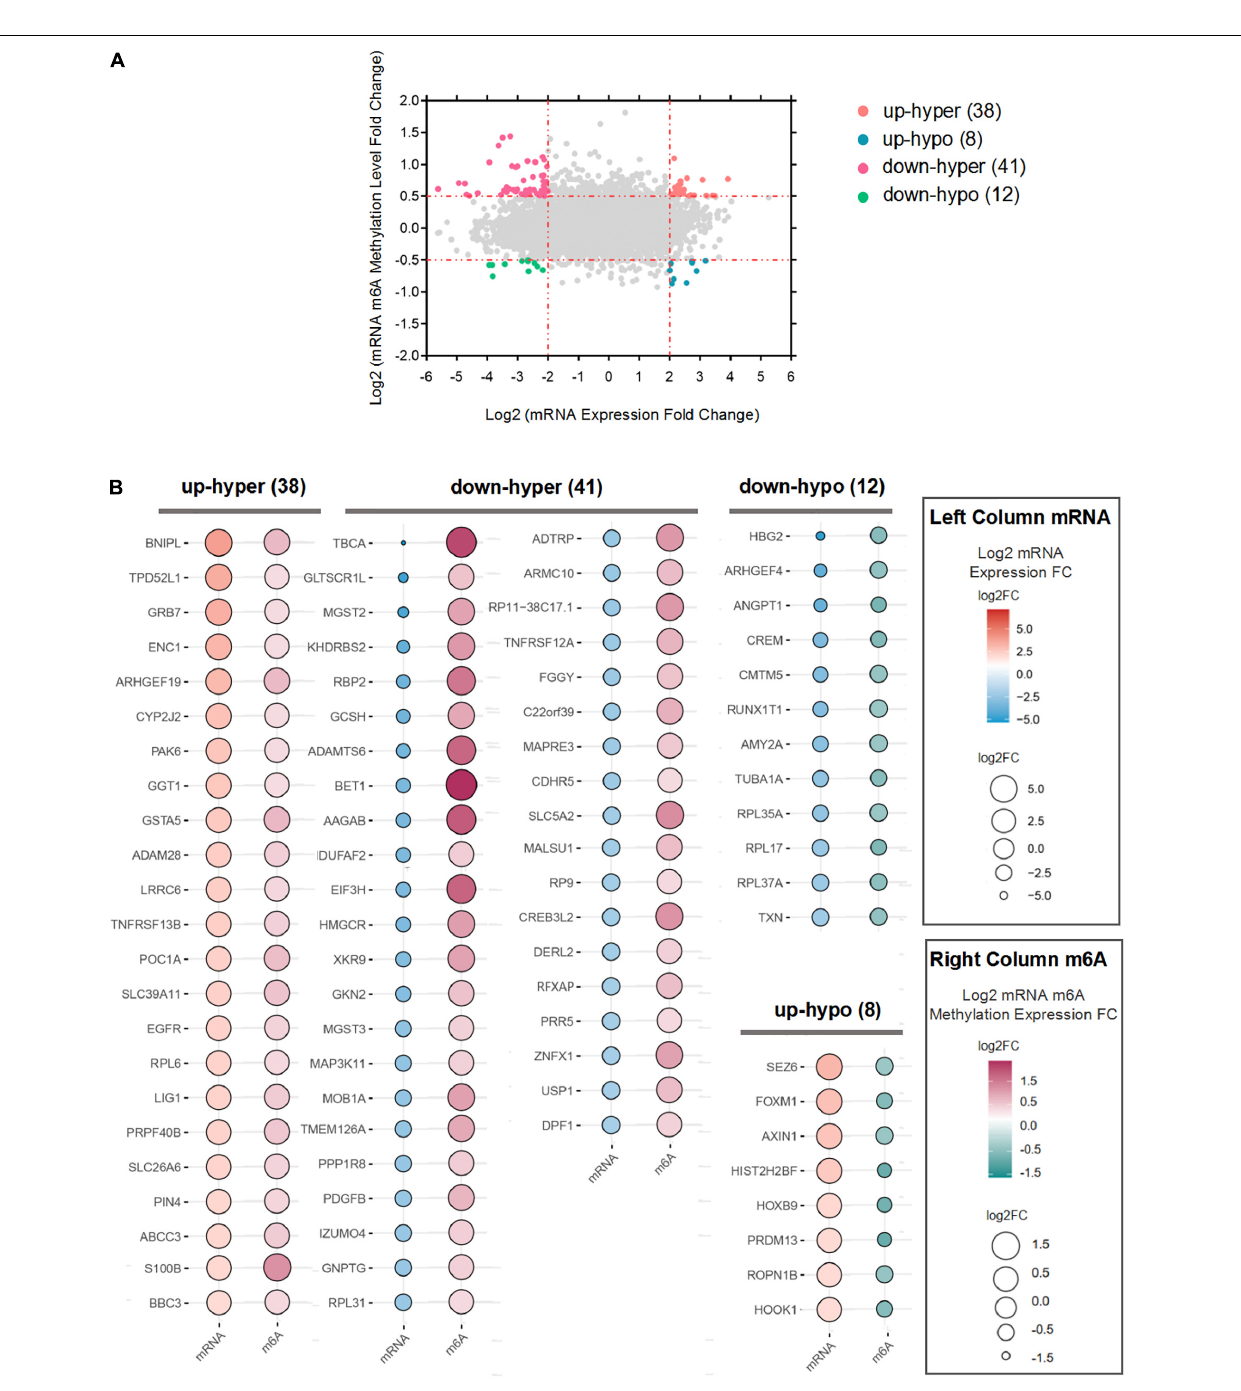
FIGURE 4 | Integration of m6A methylation and mRNA expression data to obtain m6A-regulated mRNAs. (A) Four-quadrant plots to show the mRNAs with a significant change both in m6A and mRNA levels. (B) Bubble plot showing the mRNA expression levels and m6A modification levels of m6A-regulated